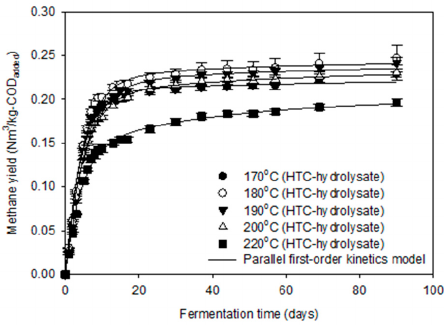
Figure 3. Cumulative methane production and optimization curves based on the parallel first-order kinetics model in the anaerobic digestion of HTC-hydrolysate (vertical bars denote standard deviations).